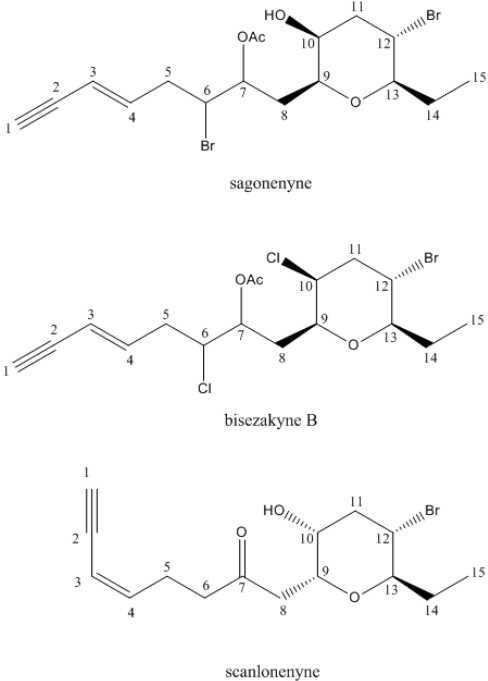
Figure 2. Structures of sagonenyne, bisezakyne-B, and scanlonenyne. Table 3. NMR spectroscopic data (400 MHz, CDCl 3 ) of sagonenyne ( 20 ).